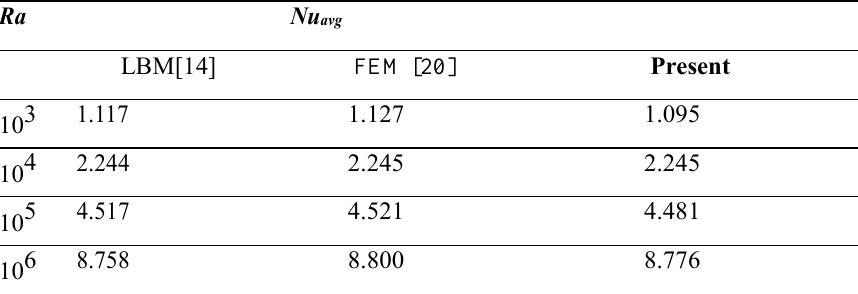
Comparison of the average Nusselt number, present outcomes, with that of the single phase fluid while Pr =